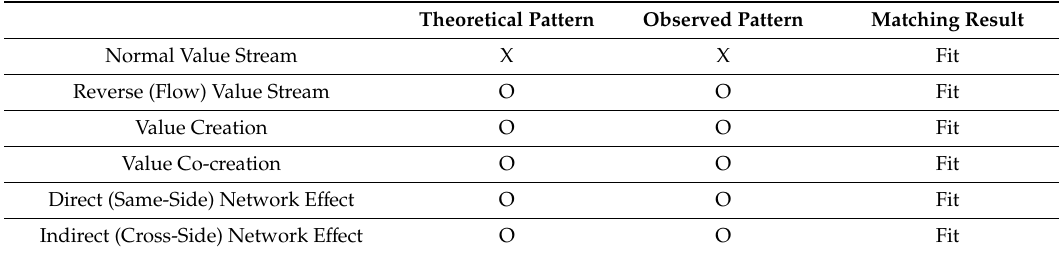
Table 3. Second type of platform business model pattern